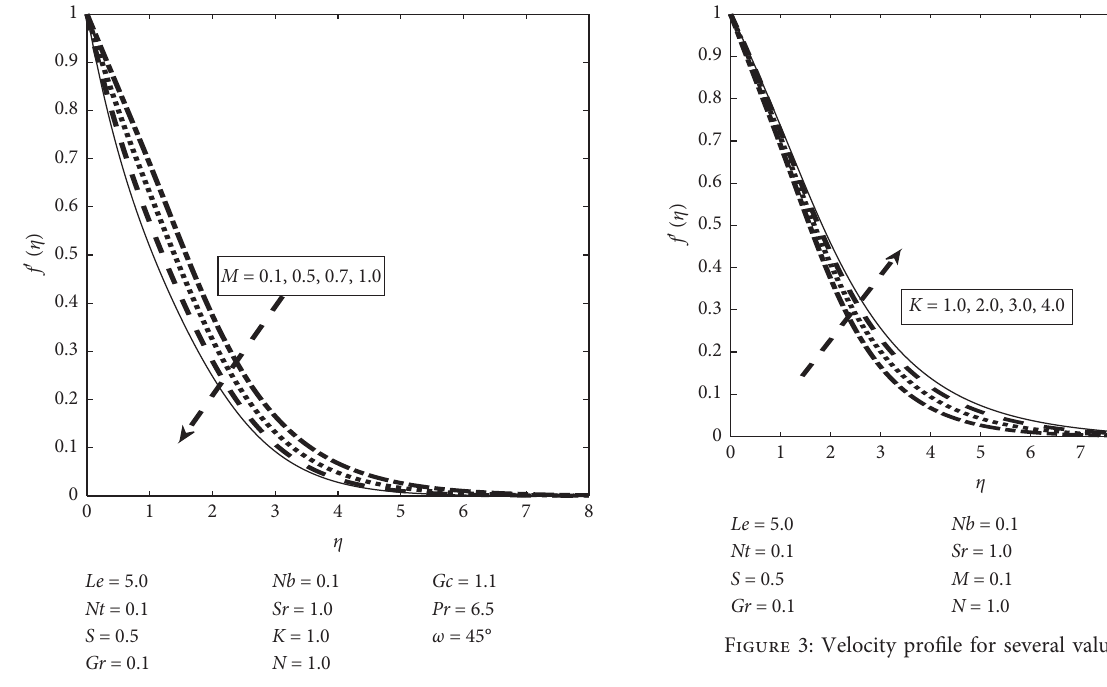
Figure 1: Velocity profile for several values of M .